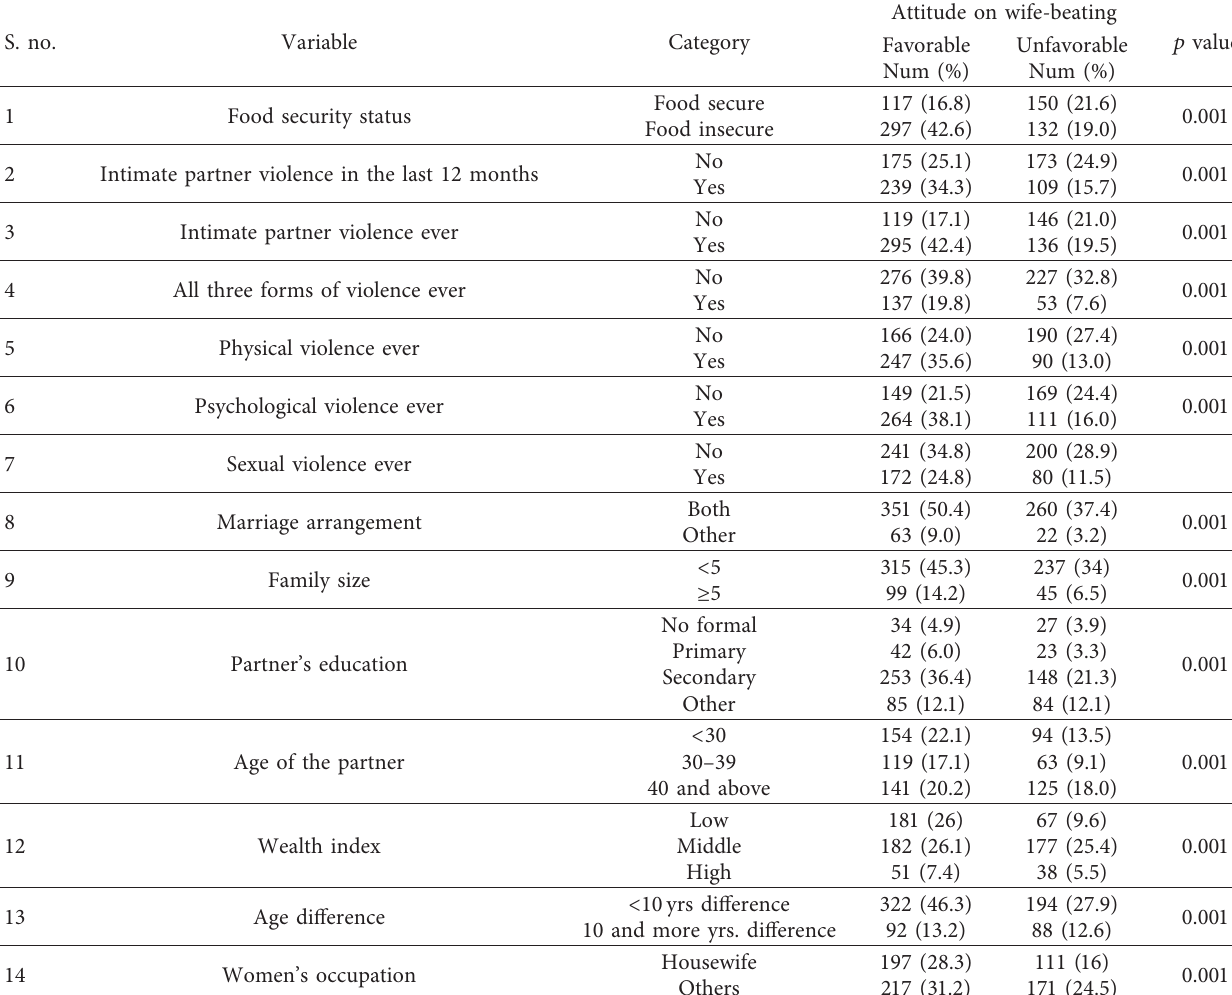
Table 2: Comparison of women’s attitude towards wife-beating by their characteristics at Arba Minch town, Southern Ethiopia, 2018. S.